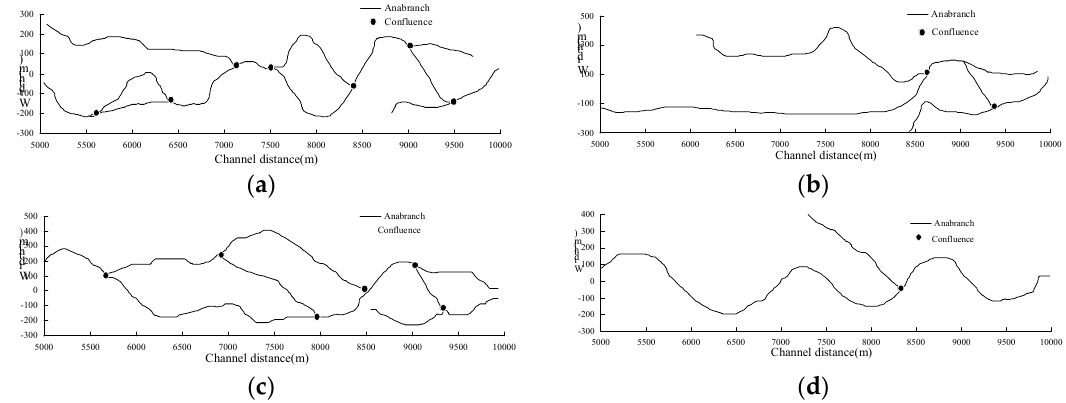
Figure 9. Sketch of the braided reach for initial and run 1–4. ( a ) Initial reach; ( b ) run 1; ( c ) run 2 and ( d ) run 4.